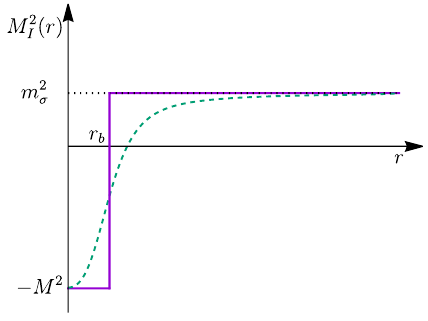
Figure 4 . The schematic picture of square well potential as an approximation of the position- dependent mass function M 2 ( r ) I